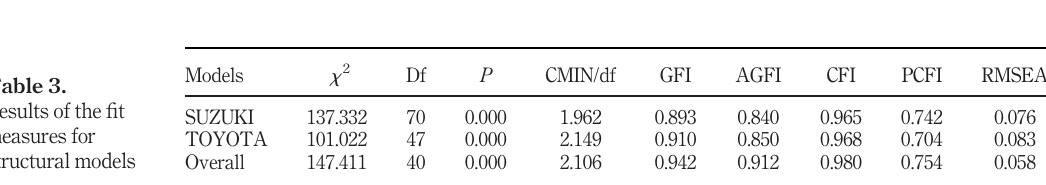
Table 2. Descriptive statistics and correlation analysis of study variables